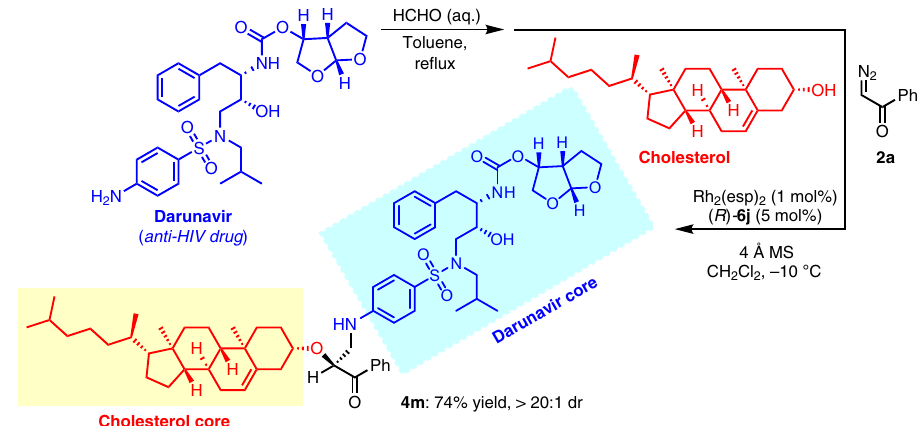
Fig. 5 Drug linkage of Darunavir and cholesterol. Using Our protocol as a linkage tool reaction to connect Darunavir and cholesterol.